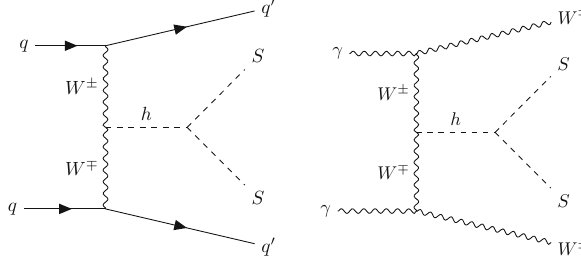
Fig. 1 Feynman diagrams for singlet scalar S pair production through the Higgs portal. Left: hadron colliders (for e + e − colliders, initial state fermions would be e ± , and final state fermions would be neutrinos). Right: γγ